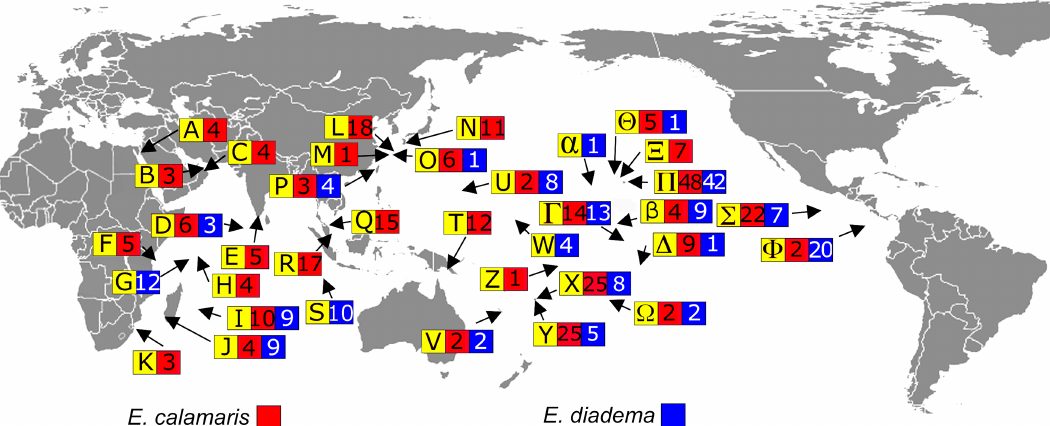
Figure 7. Collection localities of Echinothrix used in this study. Letter refers to locality (see Fig. 2 legend), number to the sample size, and colour to species. The outline of this map was downloaded from Dmthoth, CC BY-SA 3.0, via Wikimedia Commons and edited in Photoshop Elements